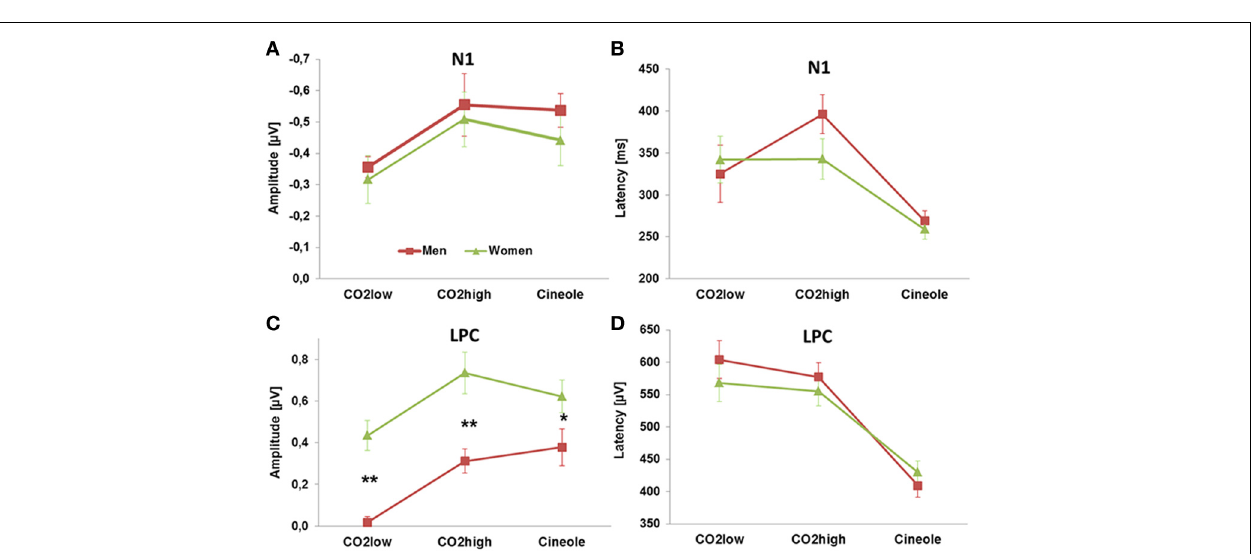
different colors under the curve. Topographical voltage distributions show the signals distribution over the scalp during the period of each microstate (B) .